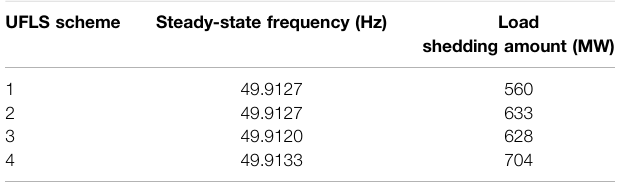
TABLE 2 | Results of different UFLS schemes considering different primary frequency control modes. UFLS scheme